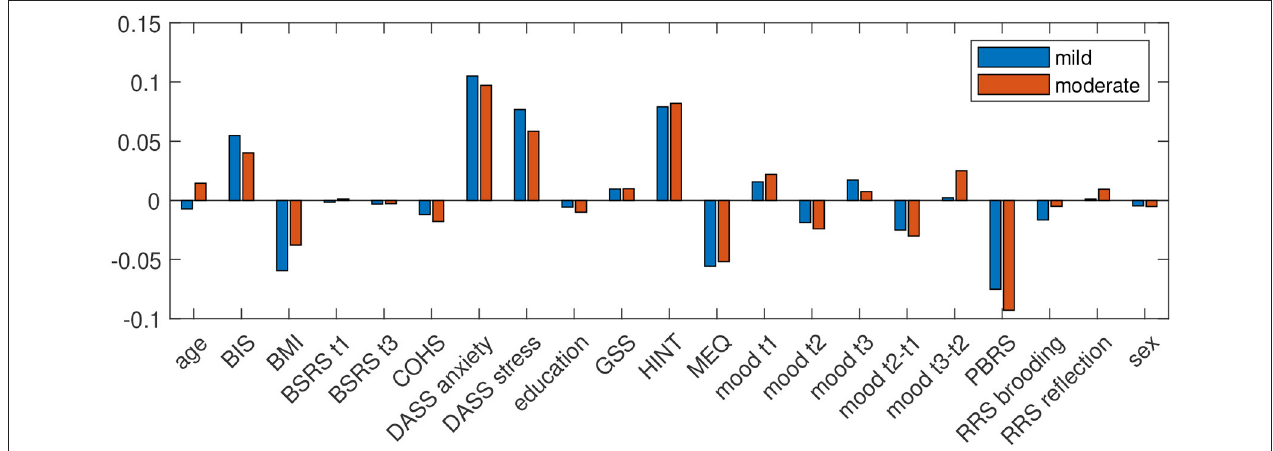
FIGURE 1 | Predictor coefficients β for each questionnaires’ importance to the model for the prediction of worsening of depressive symptoms in winter to at least mild (DASS depression score ≥ 10; blue) and moderate (DASS depression score ≥ 14; red) extent.